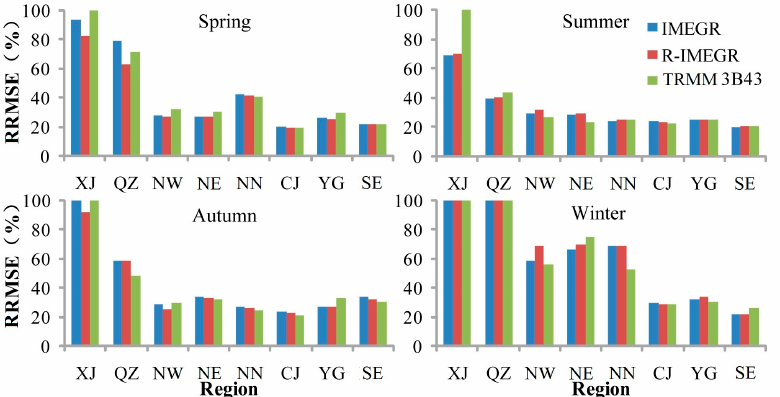
Figure 7. RRMSE values of seasonal precipitation estimates derived from IMERG, R-IMERG, and TRMM 3B43 products over the eight sub-regions.